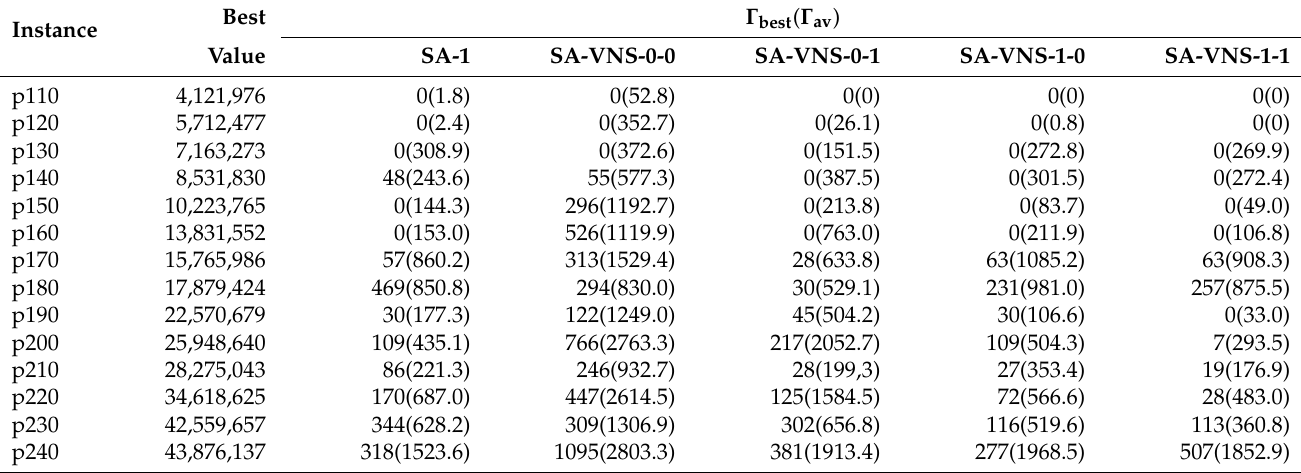
Table 4. Comparison of the objective function values for larger problem instances: best ( Γ best ) and average ( Γ av ) solution gaps to the best